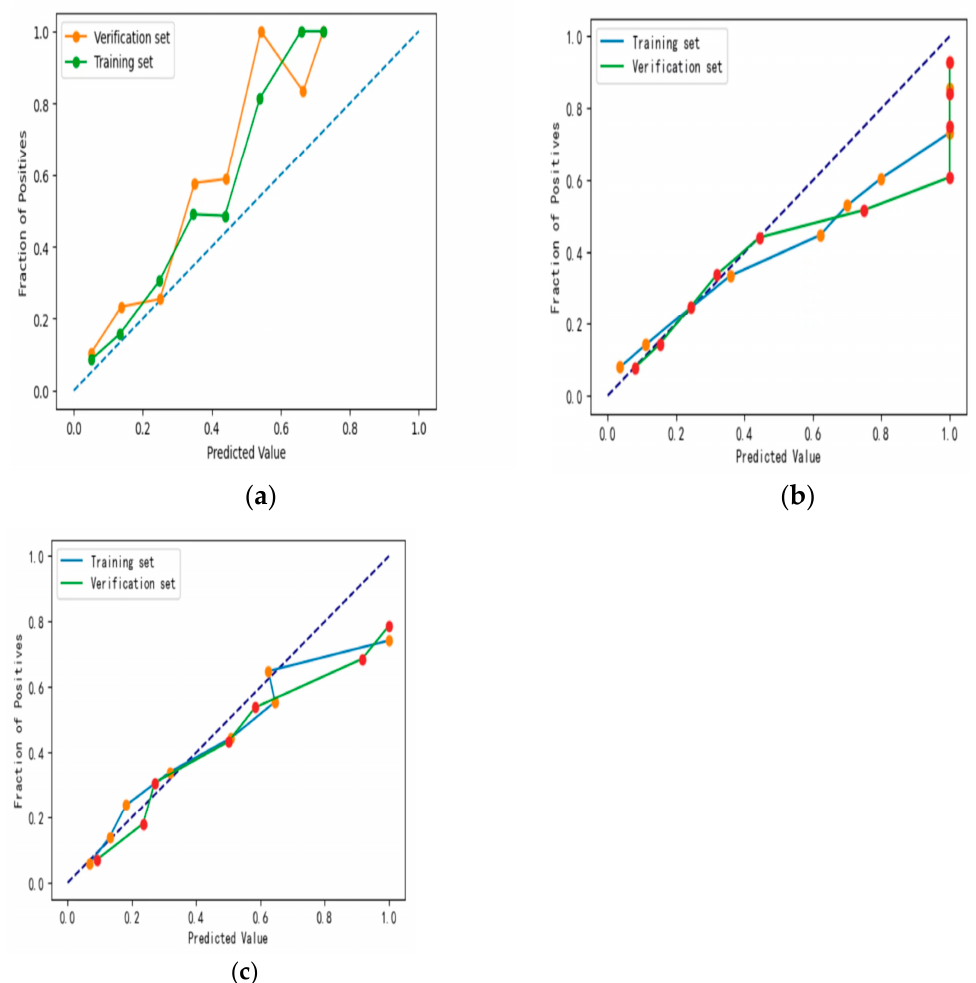
Figure 4. Calibration curves of three models: ( a ) Logistic; ( b ) CNN; ( c ) XG Boost.